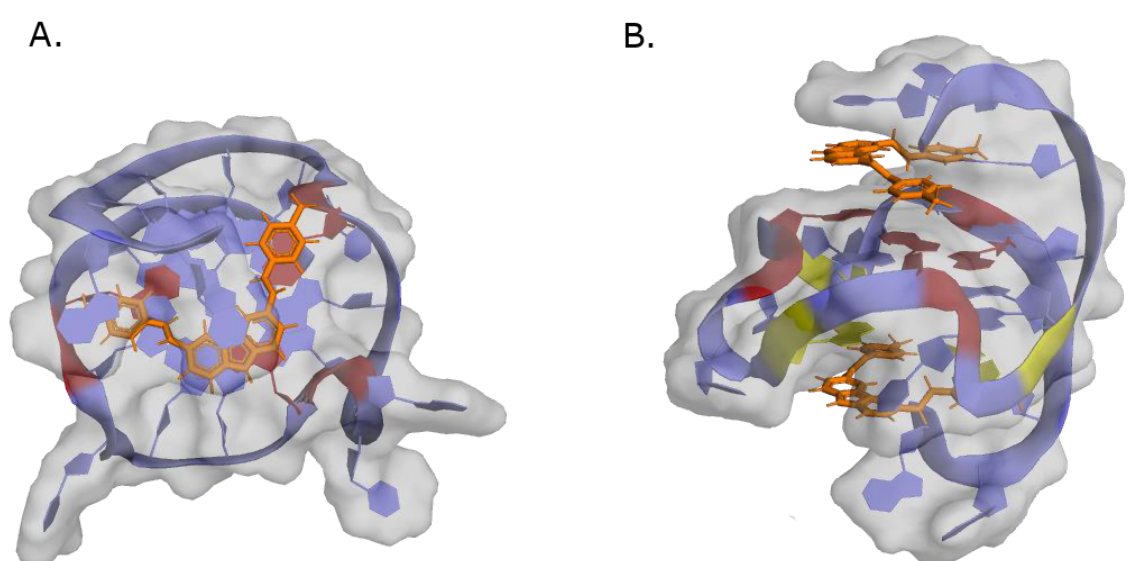
Figure 10. Representation of Compound 37 (colored sticks) in complex with a c-MYC G4 structure (cartoon). Guanines interacting with BMVC in top G-quartet at 5′ are colored red, and in yellow are the ones at 3′ G-tetrad. ( A ) represents the structure of the 1:1 complex (PDB ID: 6JJ0). ( B ) represents the structure of the 2:1 complex (PDB ID: 6O2L).